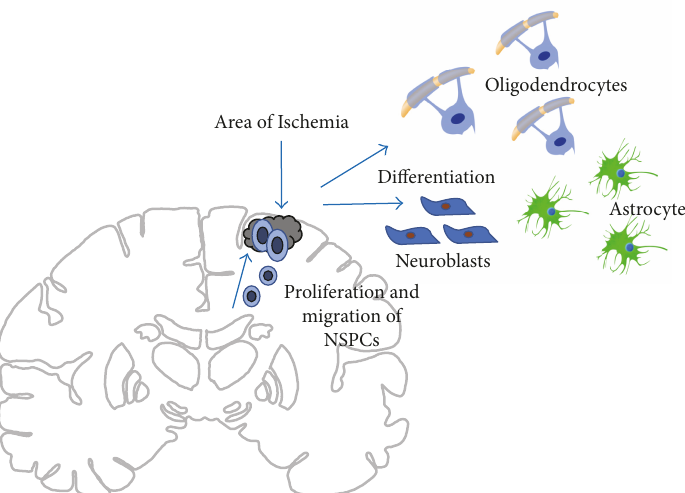
Figure 2: This fi gure demonstrates the process of neurogenesis following ischemic injury in a coronal section of the brain. Endogenous NSCs proliferate and migrate from the SVZ to areas of ischemic injury. Once they are outside the SVZ, they are able to undergo di ff erentiation into oligodendrocyte progenitors, astrocytes, and